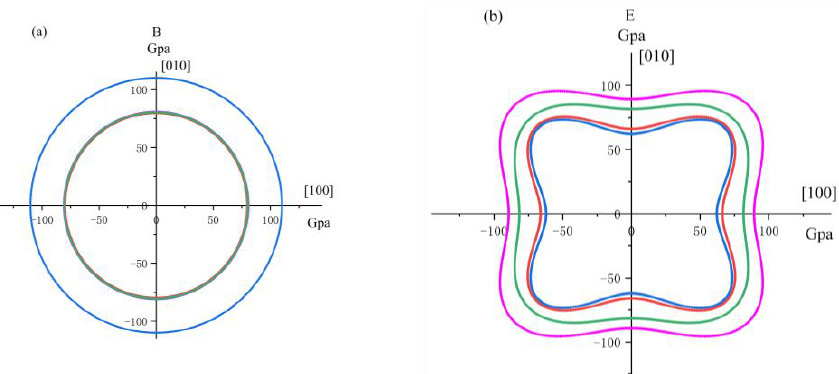
Figure 6. Three −dimensional surface structures of Young’s modulus of AuIn 2 and RE doped models. For all the graphs, the units are GPa.